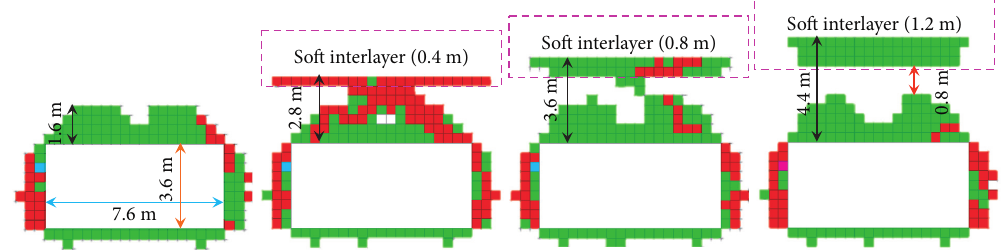
Figure 13: Distribution of plastic zone in open-off cut surrounding rock.